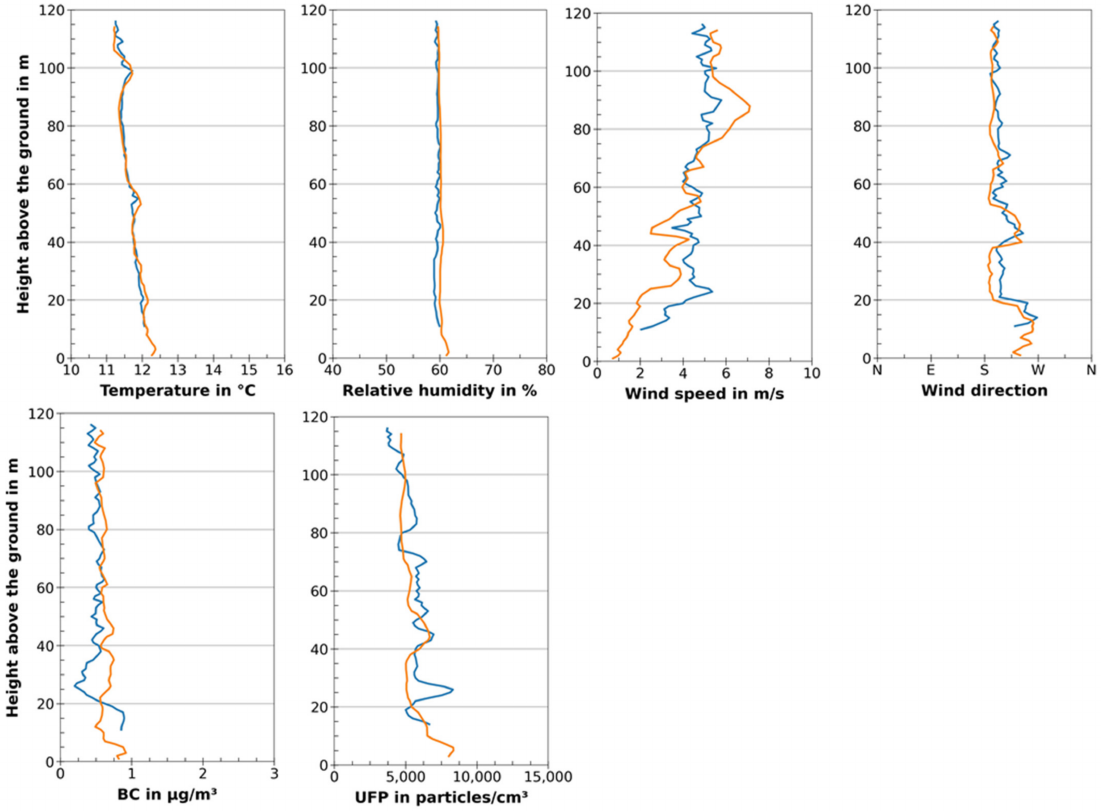
Figure 11. Vertical profiles (ascent: blue line; descent: orange line) of the meteorological parameters